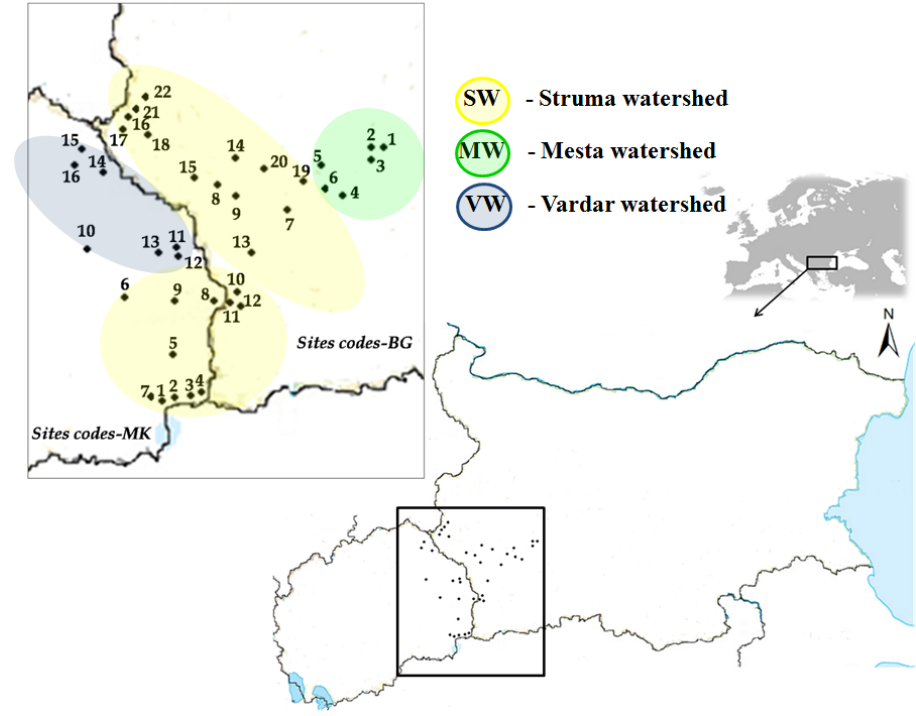
Figure 1. Map of the study area and location of the sampling sites per watersheds.